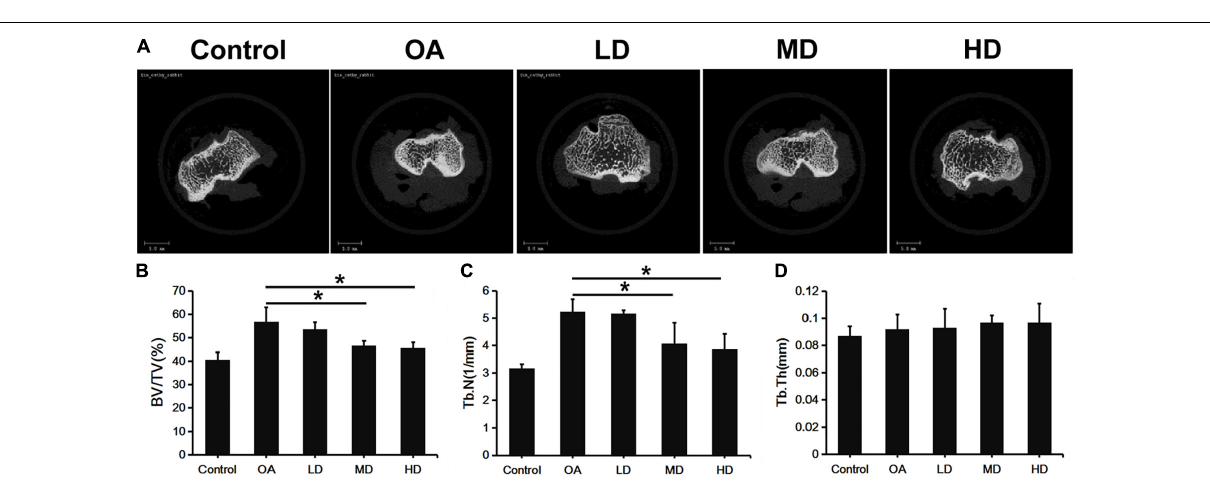
Mankin score for OA evaluation was adopted in this